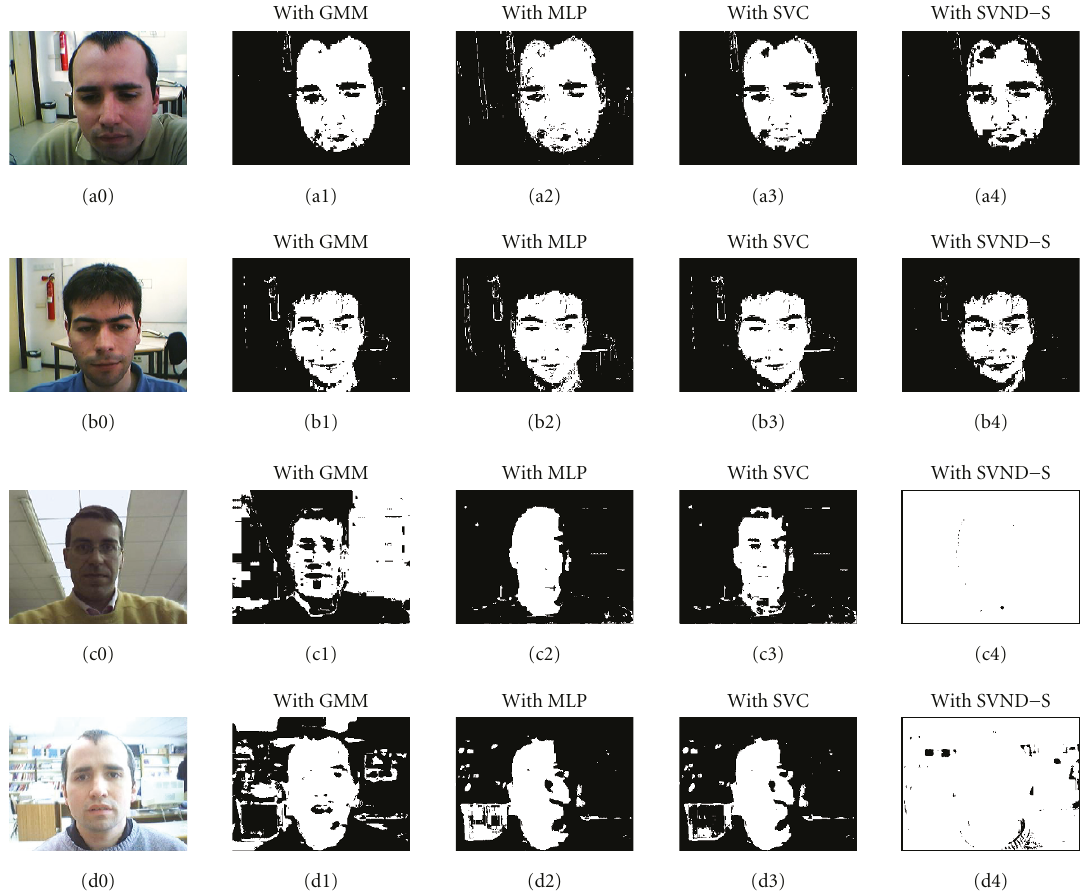
Figure 2: Examples of RGB images in the databases: ( a 0, b 0) from CdB, and ( c 0, d 0) from UdB. Classifiers correspond to GMM ( ∗ 1), MLP ( ∗ 2), SVM ( ∗ 3), and SVND-S ( ∗ 4). Nonskin pixels in black and skin pixels in white.